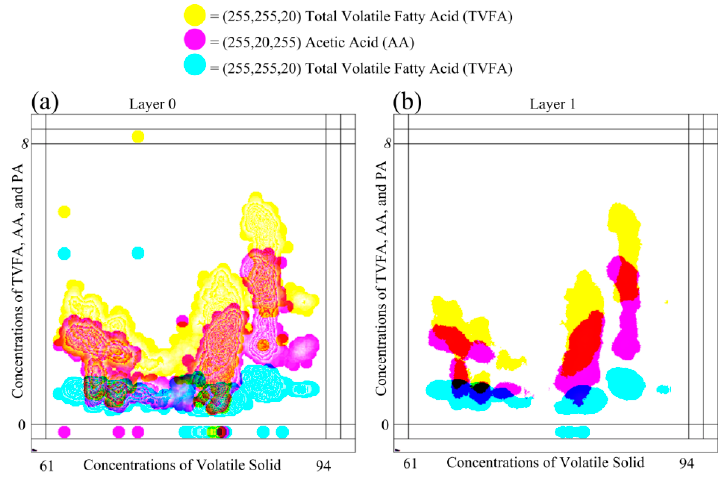
Figure 6. The MLMV ‐ GKU of two layers. ( a ) Layer 0 of the MLMV ‐ GKU; ( b ) Layer 1 of the MLMV ‐ GKU. The effective bitmap width and height are 400 and 400 pixels for representing the data of three dependent variables (concentrations of total volatile fatty acids (TVFA), acetic acid (AA) and propionic acid (PA)) against the concentration of volatile solids where each dependent variable consists of 2885 data points. All of the data are normalized using the max ‐ min normalization method and used 400, 250 and 250 pixels as new_max A for TVFA, AA and PA, respectively (relative scaling). The initial color of each variable is (255, 255, 20), (255, 20, 255) and (20, 255, 255). A circle of a radius of 10 pixels is used as the data point shape (DPS). The MLMV ‐ GKU shows density clusters of both high and low density areas of each variable by means of automatically ‐ generated contour lines, which can be easily identified by the naked eye.